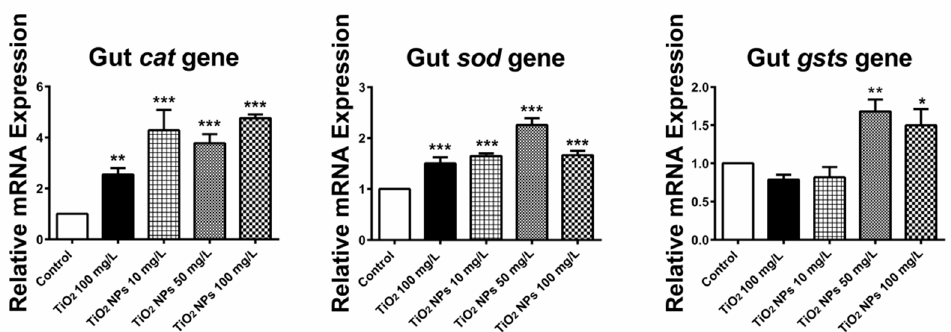
Figure 9. Change in the relative expression level of three antioxidant related genes (CAT, SOD and GSTS) in intestine tissue. *, ** and *** indicate statistically significant differences from control values at p < 0.05, p < 0.01 and p < 0.001, respectively.